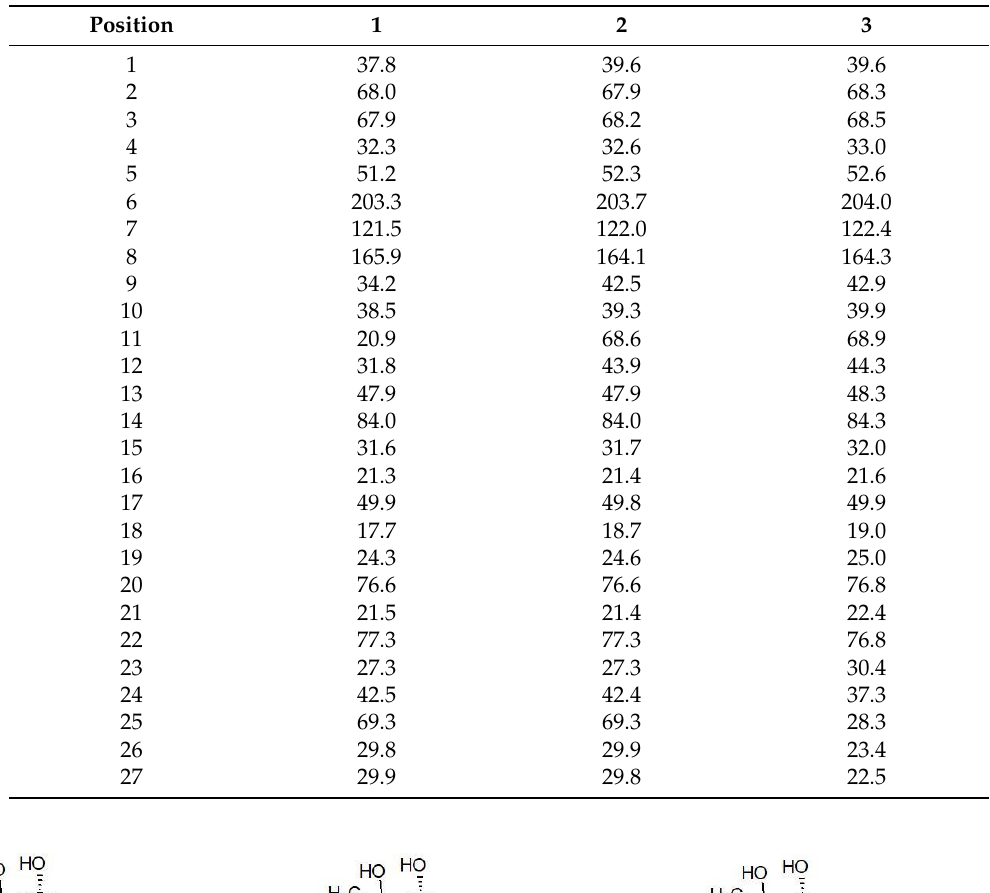
Table 1. 13 C NMR shifts (C 5 D 5 N, 125 MHz, δ in ppm) of compounds 1 – 3 isolated from the stem bark of Vitex doniana , consistent with published values [4]. 1 is 20-hydroxyecdysone, 2 is turkesterone and 3 is ajugasterone C.